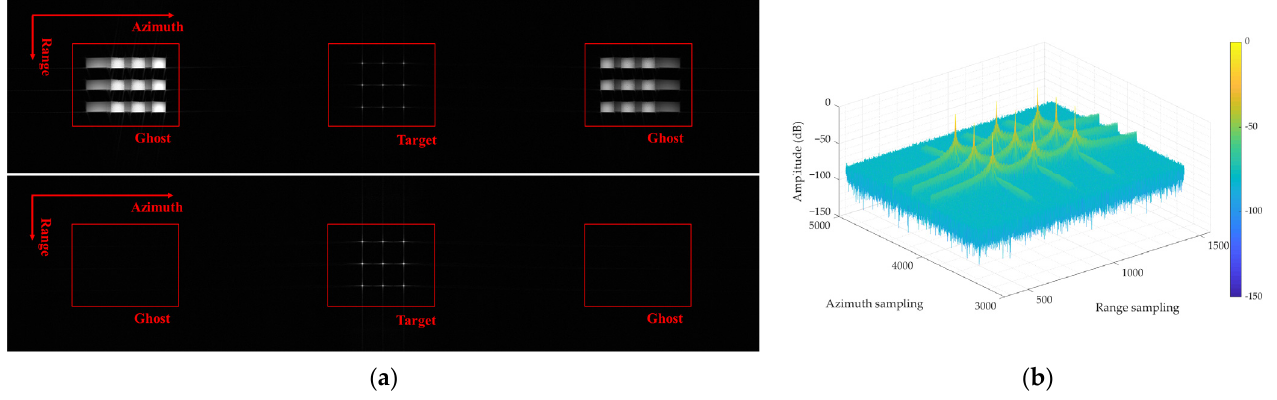
Table 4. Channel phase imbalance estimation results.